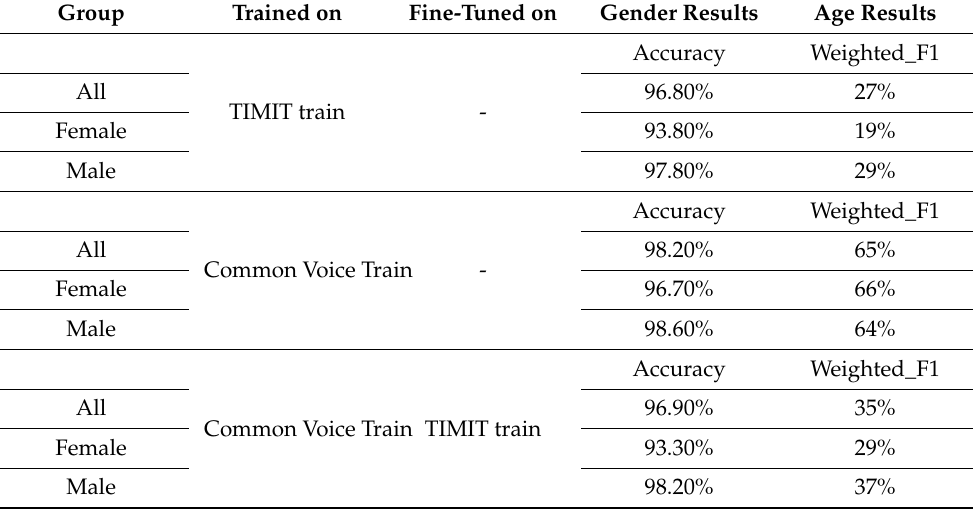
Table 11. Results on the Common Voice datatest set with a pretrained d-vector embedder as features